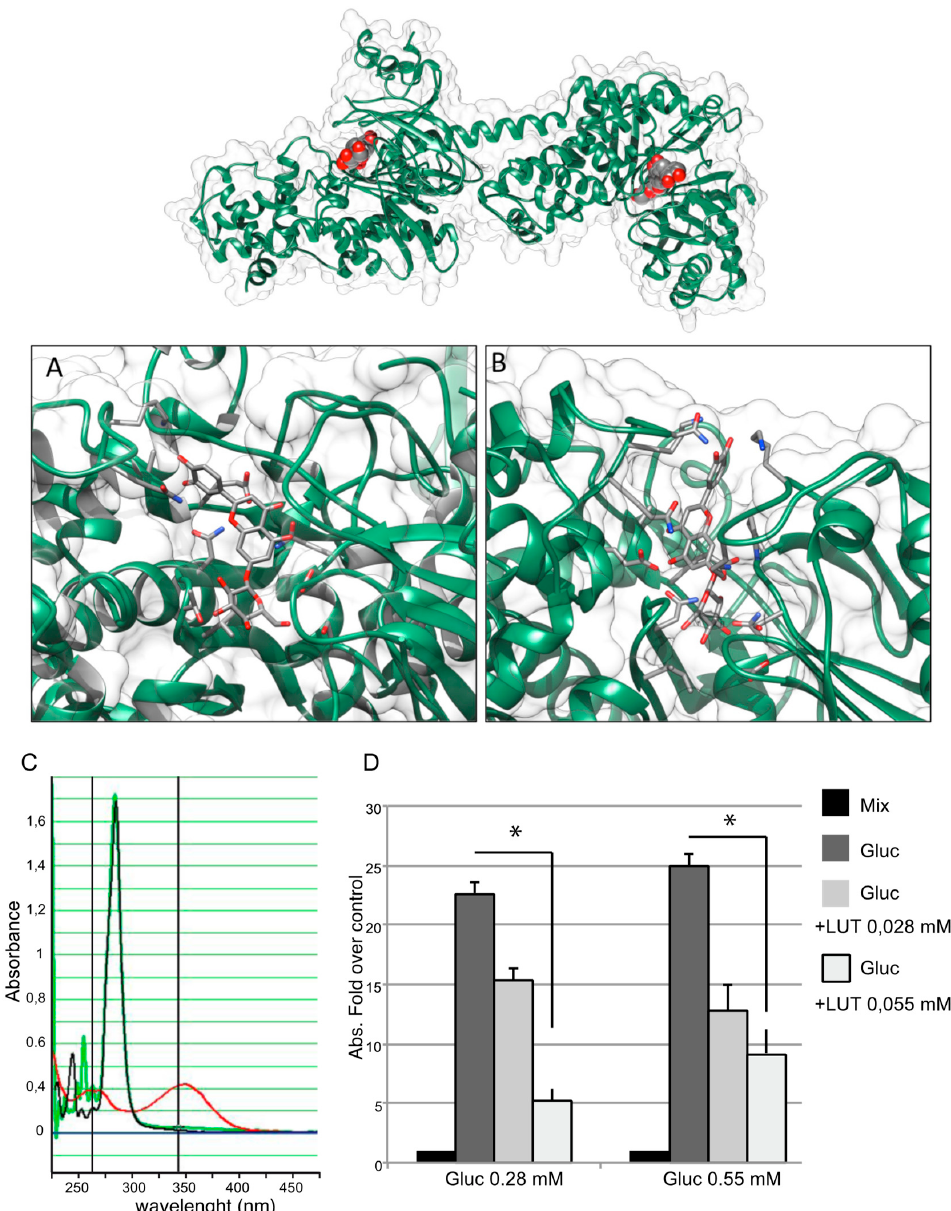
Figure 4. Top, best docking complexes between HEK2 and LUT ‐ 7G. The luteolin molecules, hosted in the active sites of HEK2, are depicted by spacefill representations colored by atom type, while HEK2 is shown as a green cartoon. ( A ) Site 1 and ( B ) site 2, detailed views of the best docking solutions. The LUT ‐ 7G molecules are depicted by stick representations, while the protein is shown as a green cartoon. The molecular views have been produced by using the program UCSF Chimera [25]. ( C ) Spectrophotometric analysis for NADH measuring. The sample containing the reaction mixture without glucose is indicated by a black curve, the sample containing LUT ‐ 7G shows a characteristic absorbance curve of luteolin with a peak around 350 nm (red curve). When the LUT ‐ 7G was added to the reaction mixture (green line) the absorbance peaks disappeared. ( D ) The presence of NADH was evaluated measuring absorbance at 340 nm. The data are expressed as fold over control (absorbance of reaction mix), in the left group a concentration of glucose of 0.28 mM was used, and two concentrations of LUT ‐ 7G of 0.028 and 0.055 mM, respectively. In the right ‐ hand group of columns, a concentration of glucose of 0.55 mM was used. In both experiments a reduction of NADH synthesis is visible. t ‐ test, * p < 0.05.